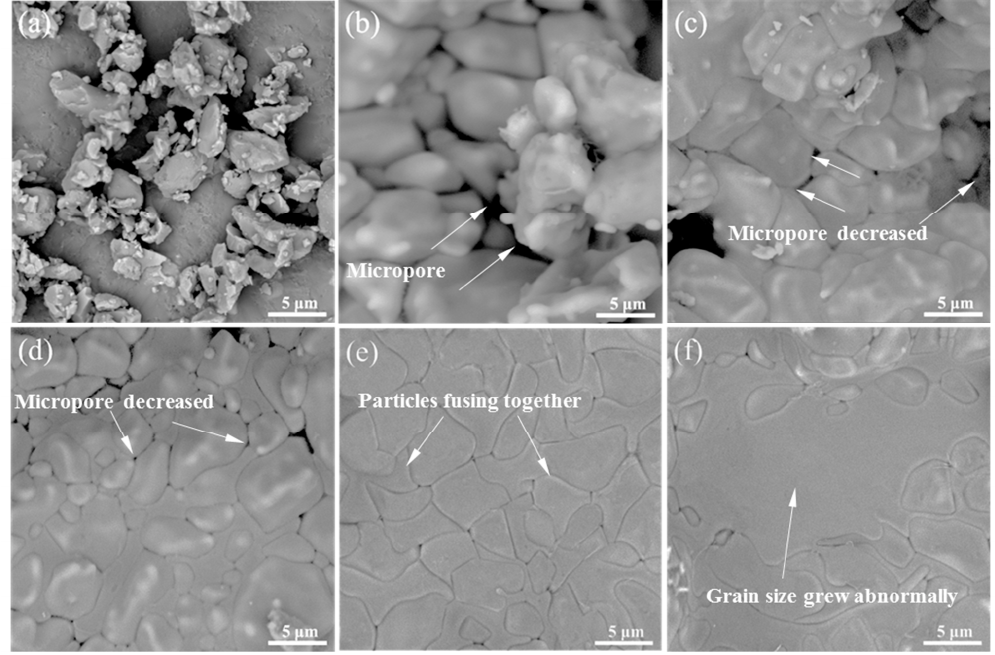
Figure 2. SEM micrographs of the ( a ) tetracalcium phosphate (TTCP) particles and the TTCP scaffolds fabricated at laser powers of ( b ) 6 W, ( c ) 7 W, ( d ) 8 W, ( e ) 9 W, and ( f ) 10 W.